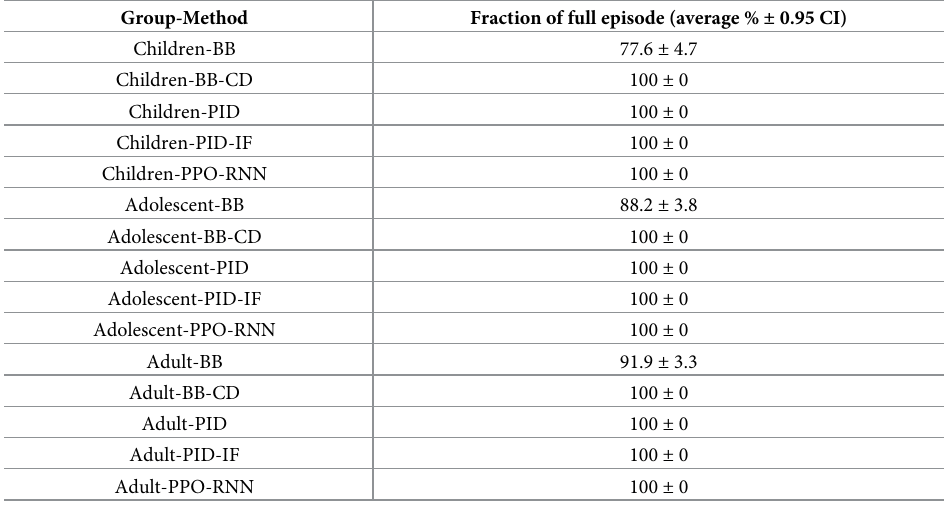
Table 3. Fraction of completed 10-day evaluation reached for each method and